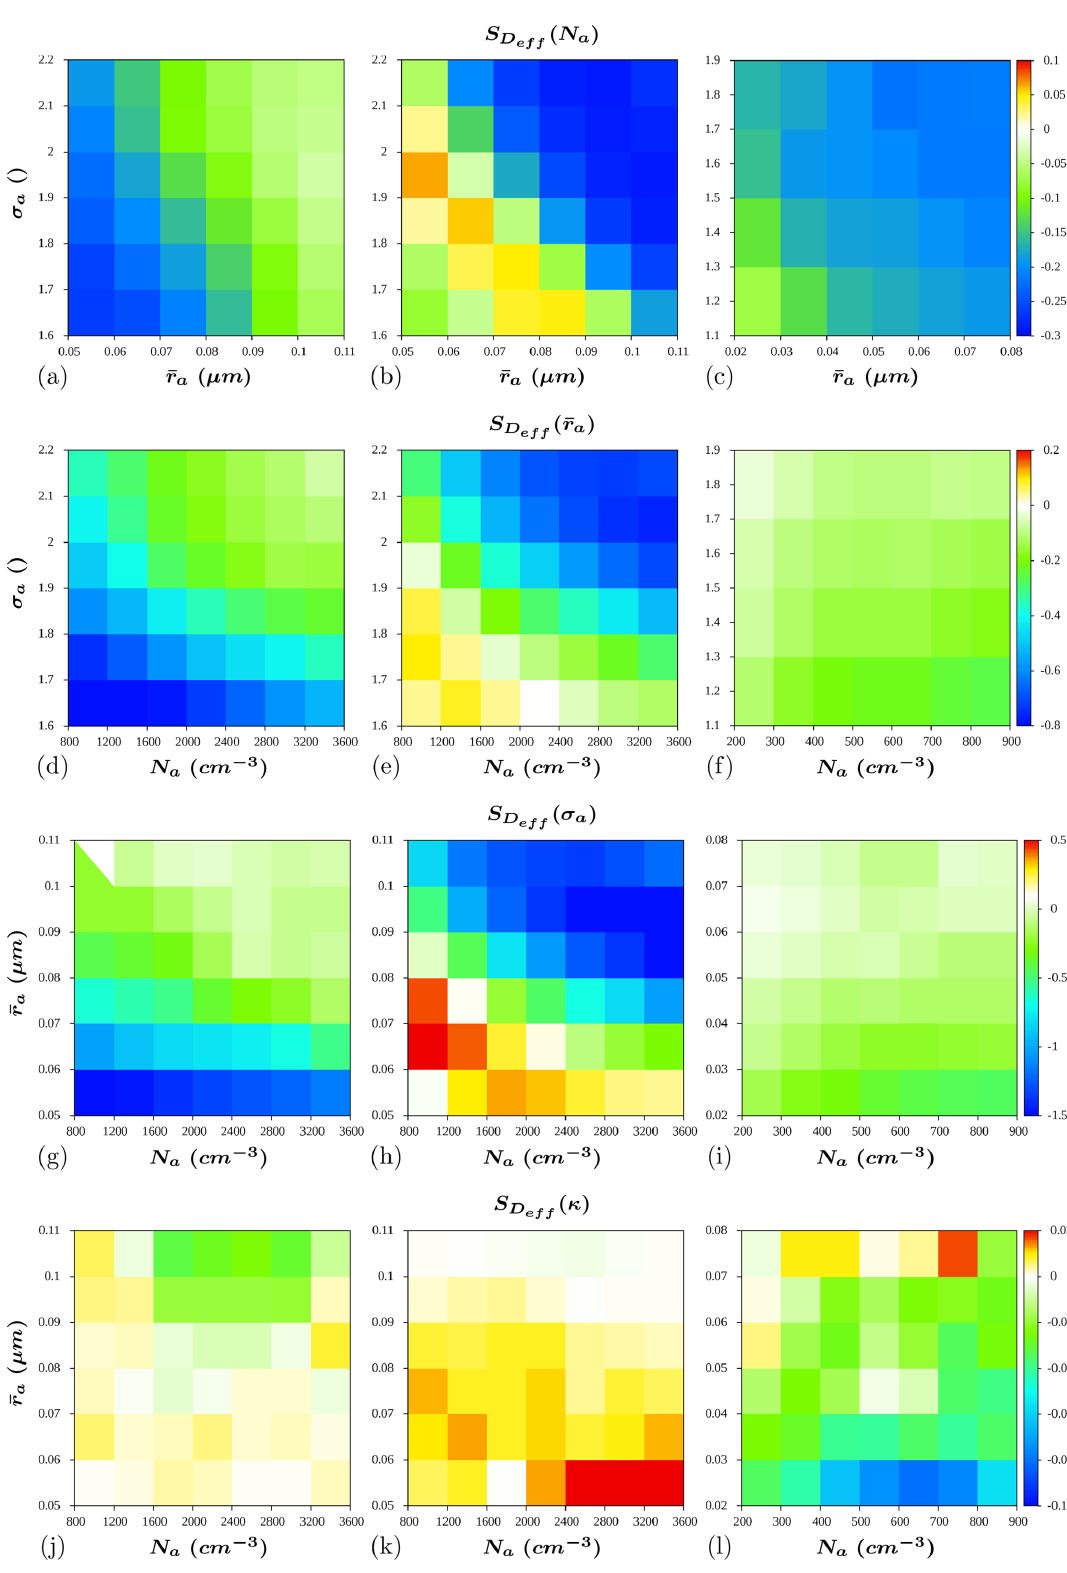
Figure 9. Sensitivity of D eff to the aerosol properties in three different configurations of the model: with entrainment and bins for the aerosols (a, d, g, j) , without entrainment (b, e, h, k) and without bins for the aerosol (c, f, i, l)